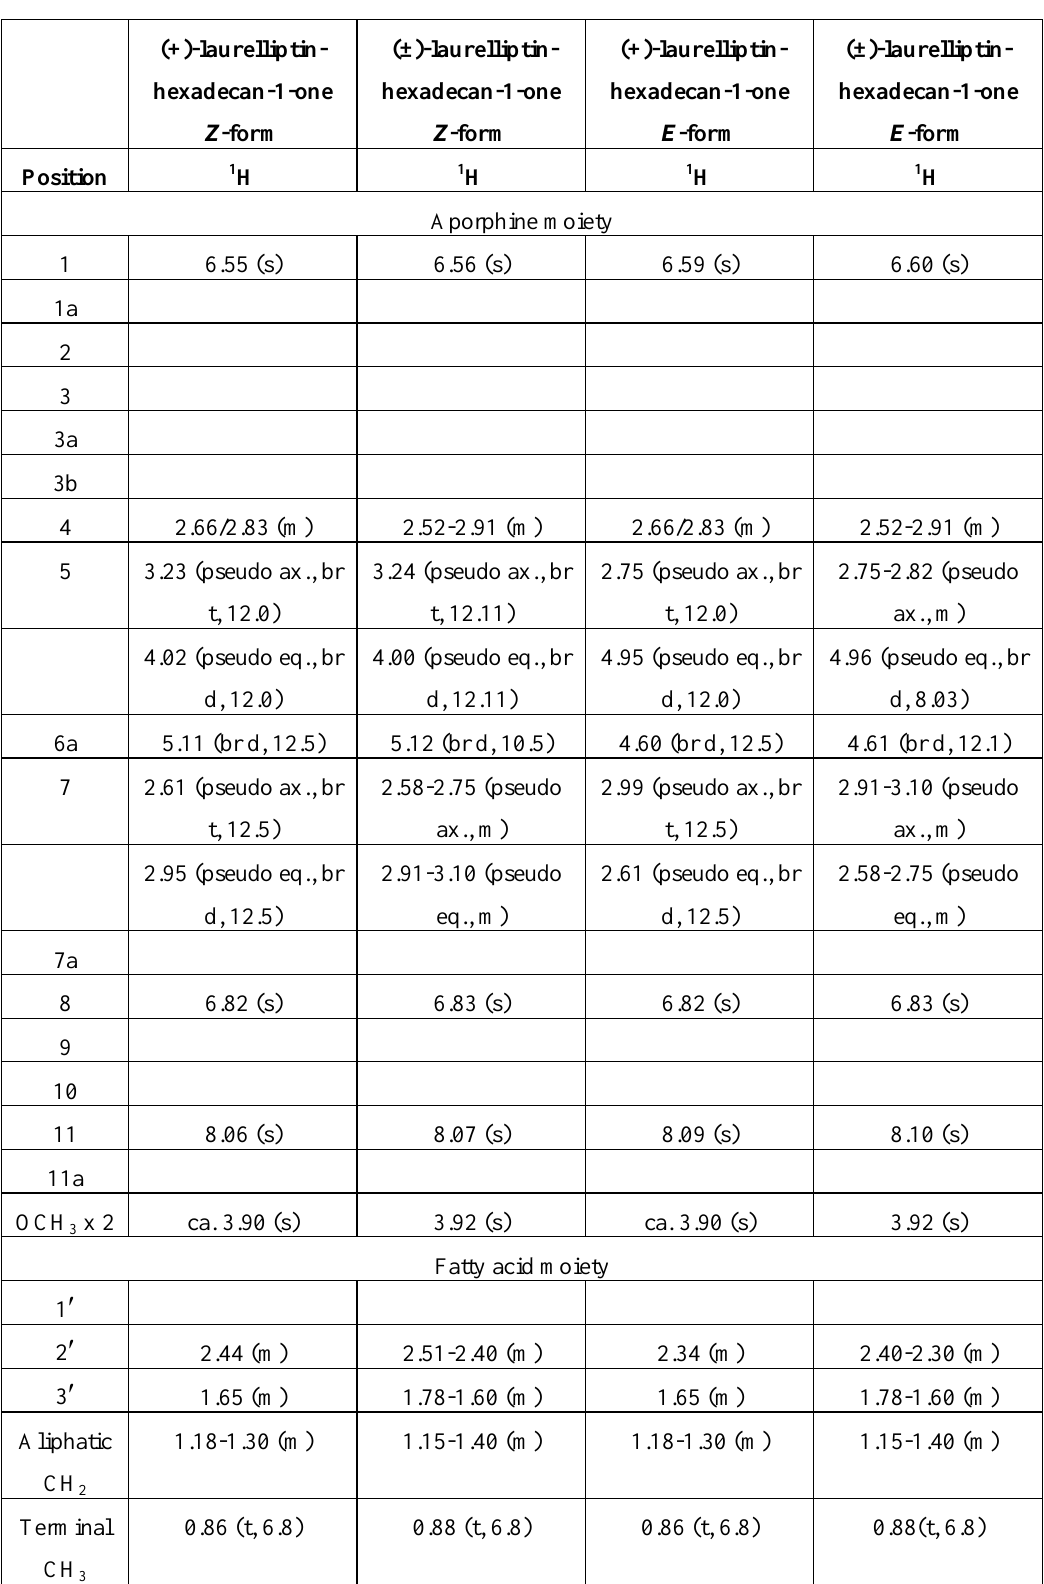
Table 1 . Comparison of 1 H-NMR spectral data between (+)-laurelliptinhexadecan-1-one (600 MHz, CDCl ) and (±)-laurelliptinhexadecan-1-one (300 MHz, CDCl 3